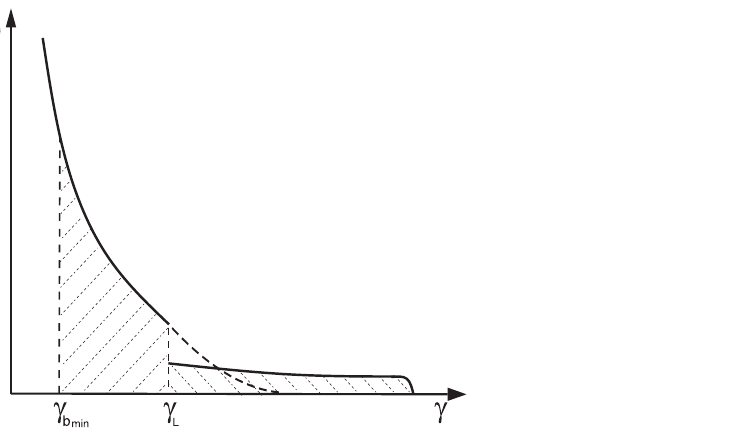
Figure 3. One-dimensional distribution function of the re-accelerated primary beam electrons through Landau damping of parametrically excited L